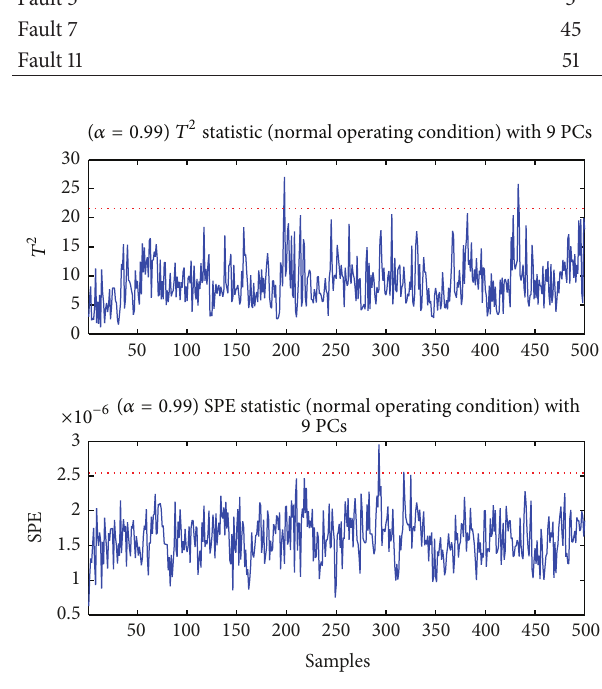
Figure 2: The PCA statistics under normal conditions.